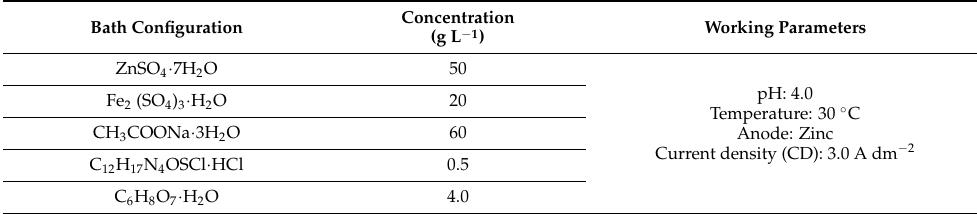
Table 1. The deposition parameters of the single-layer and multilayer coatings.